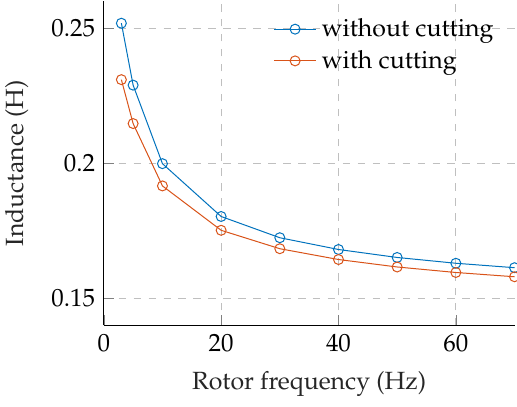
Figure 10. Comparison of magnetizing